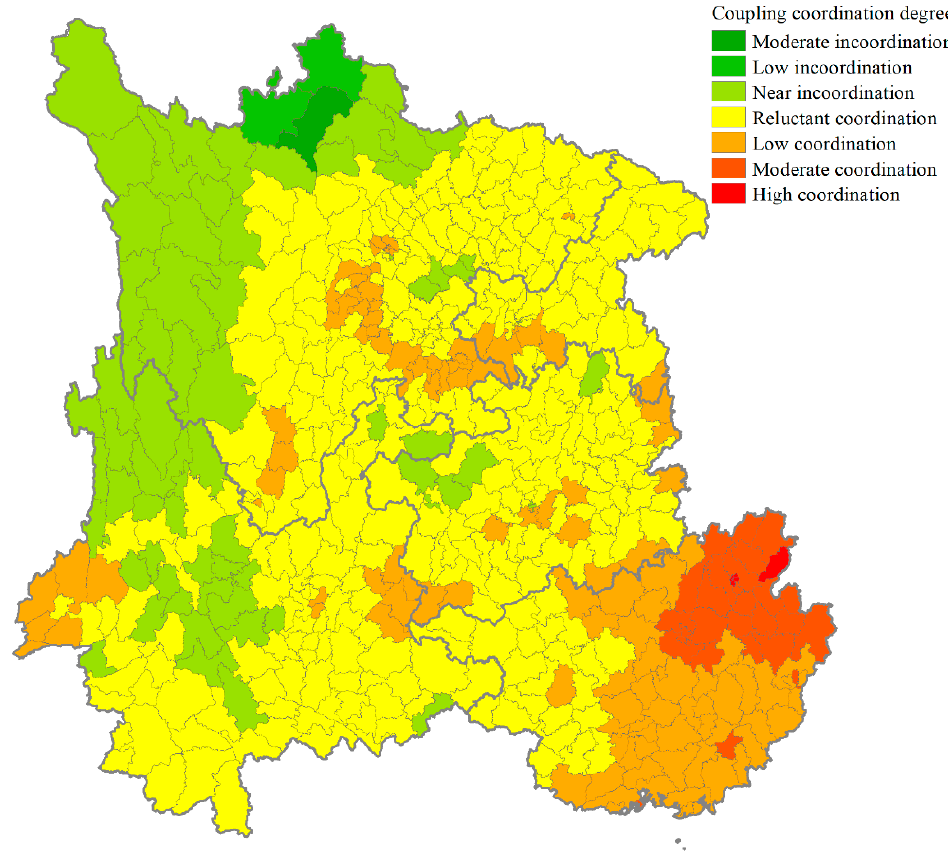
Figure 7. Spatial distribution of coupling coordination degree between water resource accessibility and water demand elements.